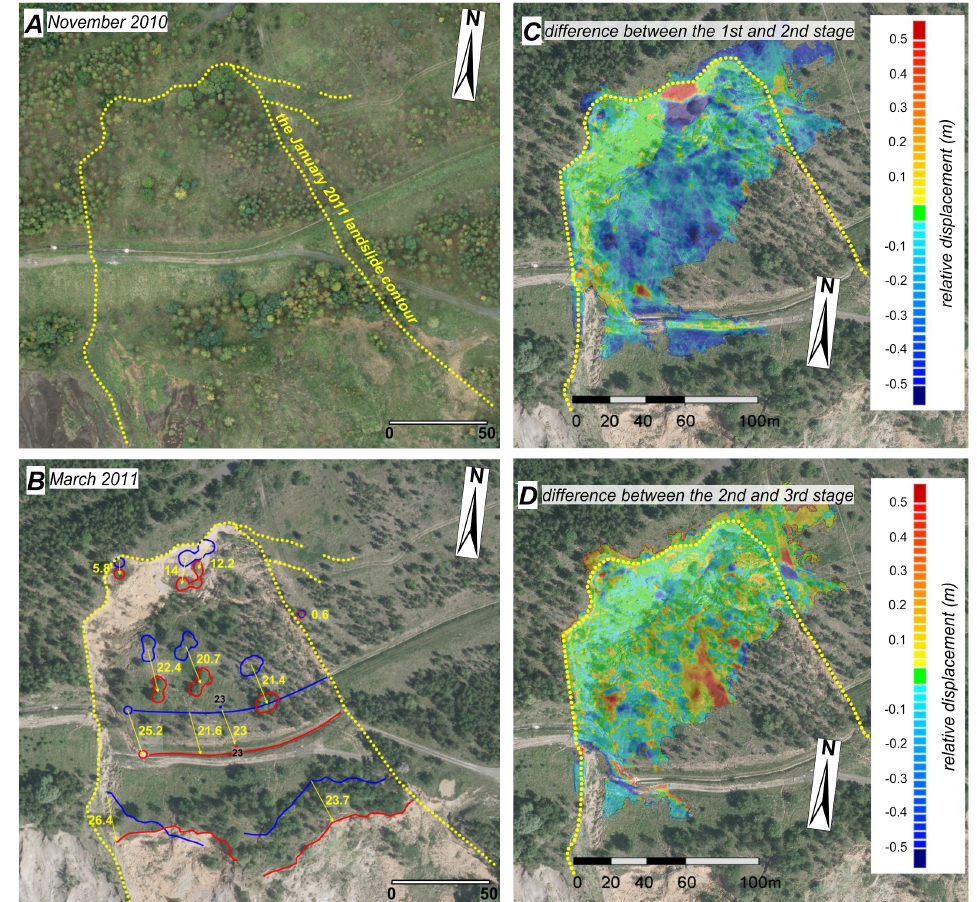
Fig. 4. Left: the orthophotos from 2010 and 2011 with the contours of the landslide body (dashed yellow line). (A) , the situation before the landslide. In (B) the orthophoto from 2011 shows the original (blue) and displaced (red) positions of selected objects for which the displacement vectors (yellow arrows) and horizontal displacement in metres (yellow numbers) were identified. Point 23 represents a key geodetic marker as its position was measured both before and after the main period of landslide activity. Right: the differential models that show the relative displacement within the body of the landslide in 2011. (C) presents the difference between the 1st and 2nd stage, while (D) presents the difference between the 2nd and 3rd